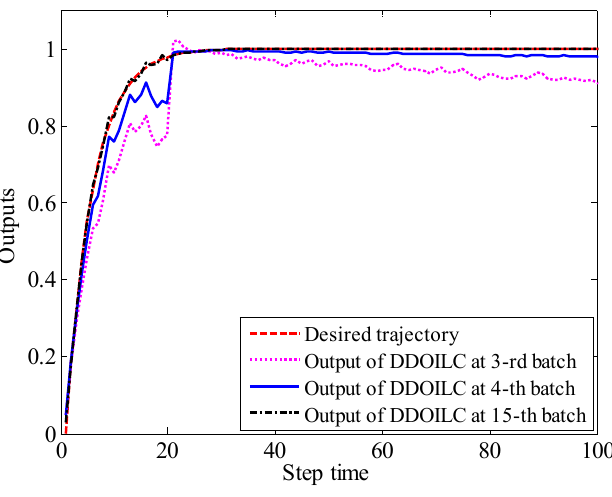
Figure 5. Outputs of the DDOILC with ω 1 = ω 2 = 0.5.